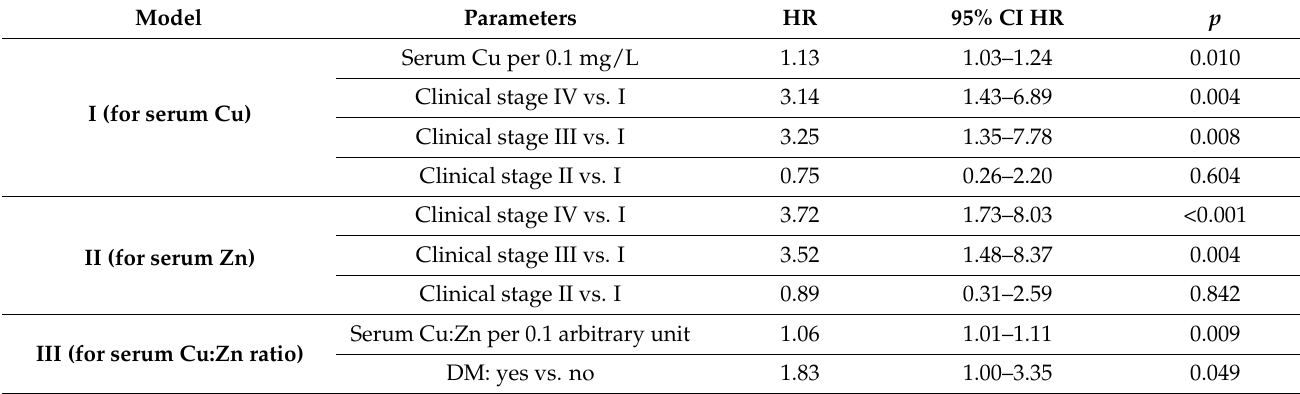
Table 4. Multiple Cox regression models predicting lung cancer